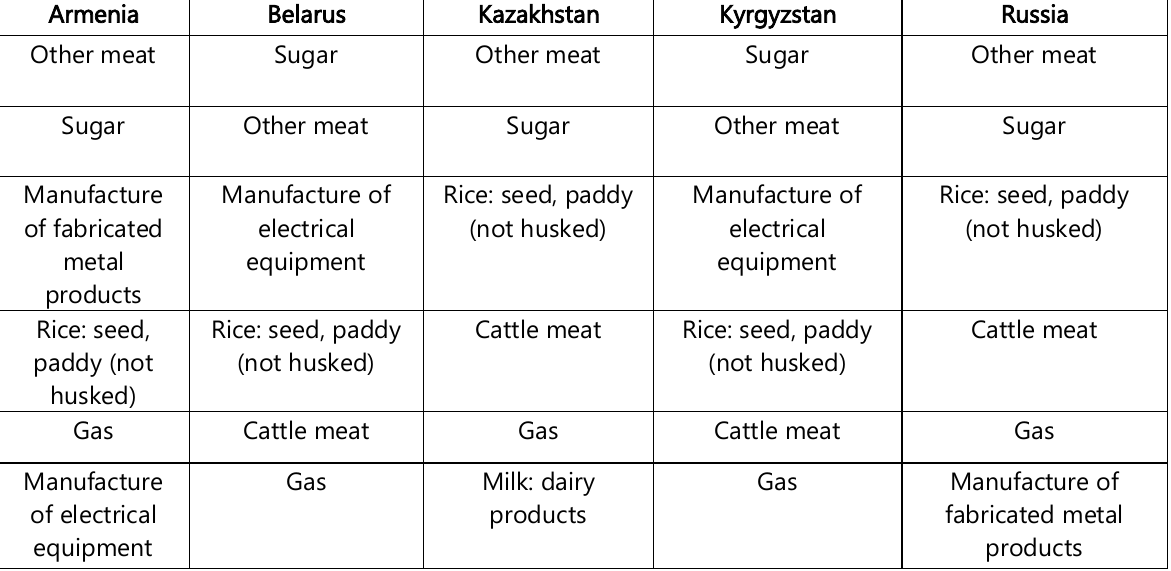
Table 3: List of Sensitive Products (partner Pakistan) (Source: Own